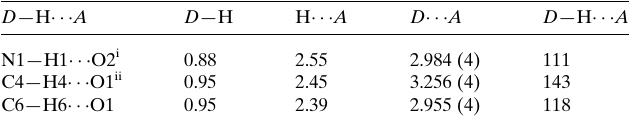
Table 1 Hydrogen-bond geometry (A˚ , (cid:2) ).